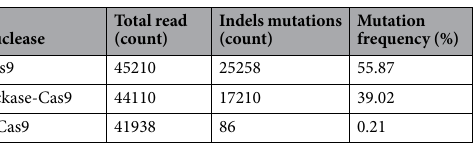
Table 2. Frequency of mutations induced by Cas9, nickase-Cas9 and d-Cas9 with a pair of sgRNAs.